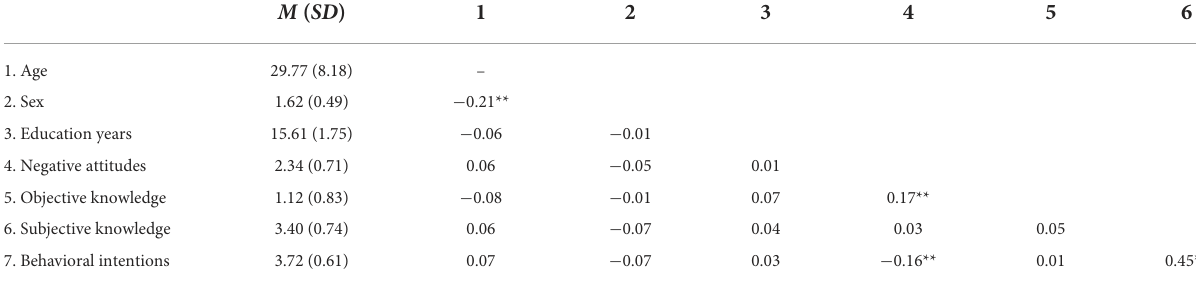
TABLE 2 Means, standard deviations, and correlations of study 1 variables ( N = 328).